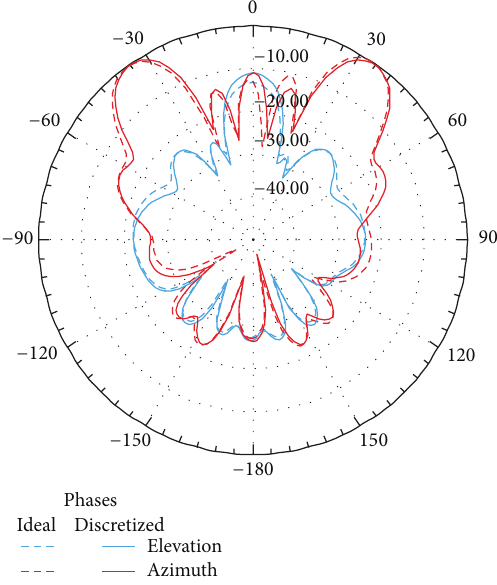
Figure 12: Pattern steered by 36 ∘ generated by a virtual array of 5 contiguous subarrays on the full cylindrical array. Dashed lines are obtained with ideal phase shifts, solid lines with discretized phase